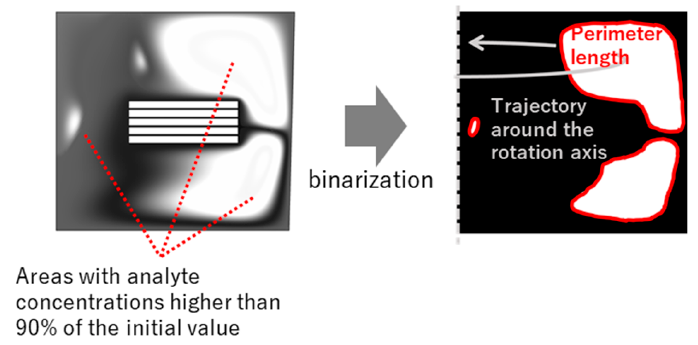
Figure 3. An imaging process for calculation of high concentration area.